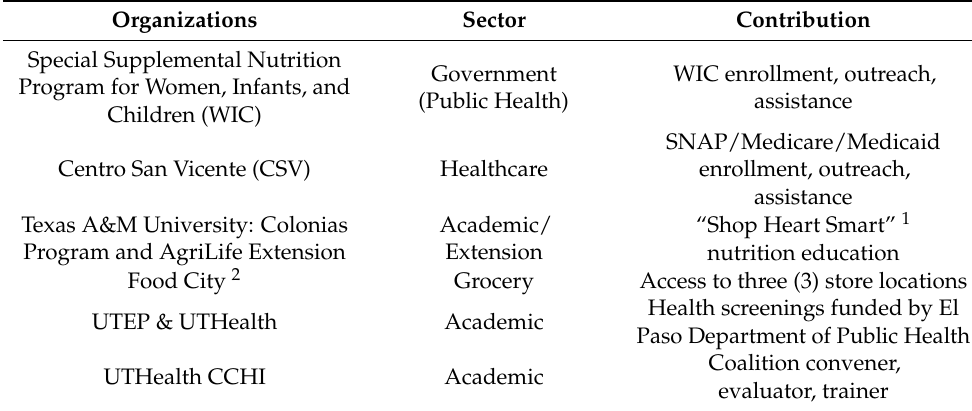
Table 1. IPOC Member organizations and